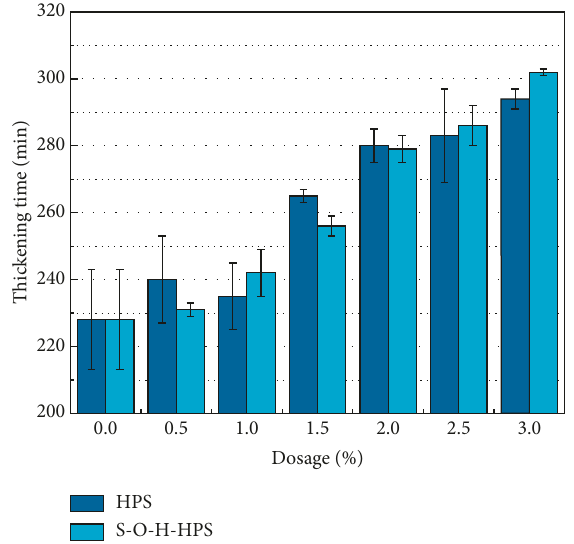
Figure 5: Variation of cement slurry thickening time with HPS, H- HPS, and S-O-H-HPS dosage.